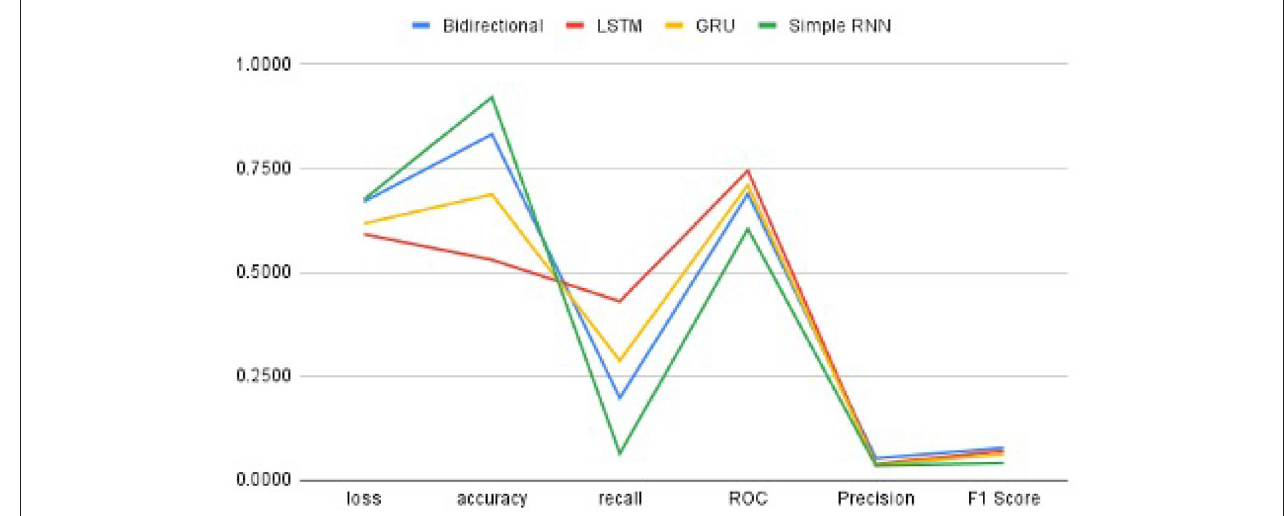
FIGURE 5 | The Performance metrics of RNN architectures with one epoch.